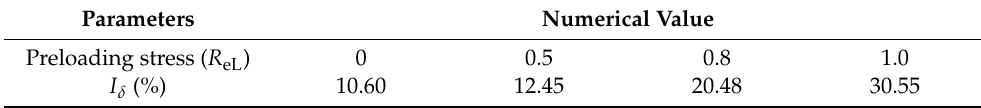
Figure 8. Stress–strain curves of L80 steel with different preloading stresses ( a ) and variation of the SCC susceptibility of L80 steel with different preloading stresses ( b ). Table 6. The SCC susceptibility of L80 steel under different preloading stress.